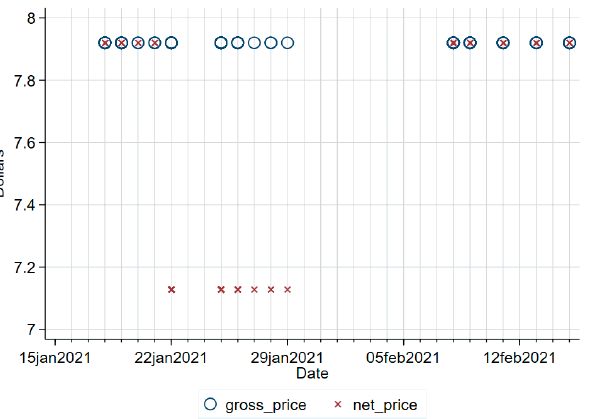
Figure 3. Example gross and net prices for a 6-pack of Colgate Cavity Protection Toothpaste with